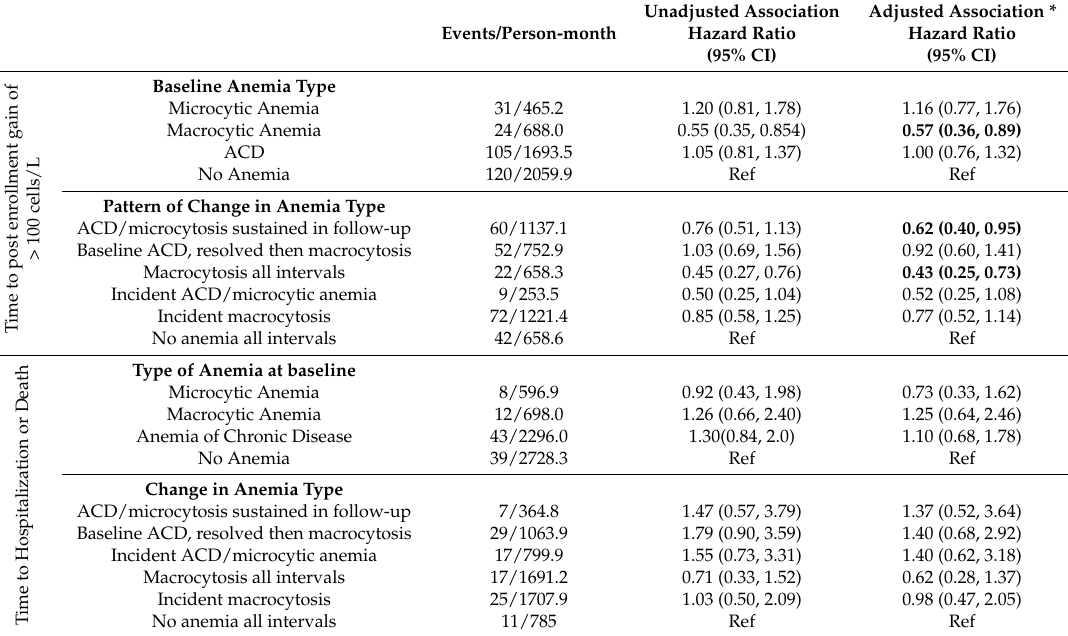
Table 5. The time to post enrollment gain of at least 100 CD4 cells/L, hospitalization or death in relation to anemia type at the onset of antiretroviral therapy among adult persons living with HIV from Uganda.